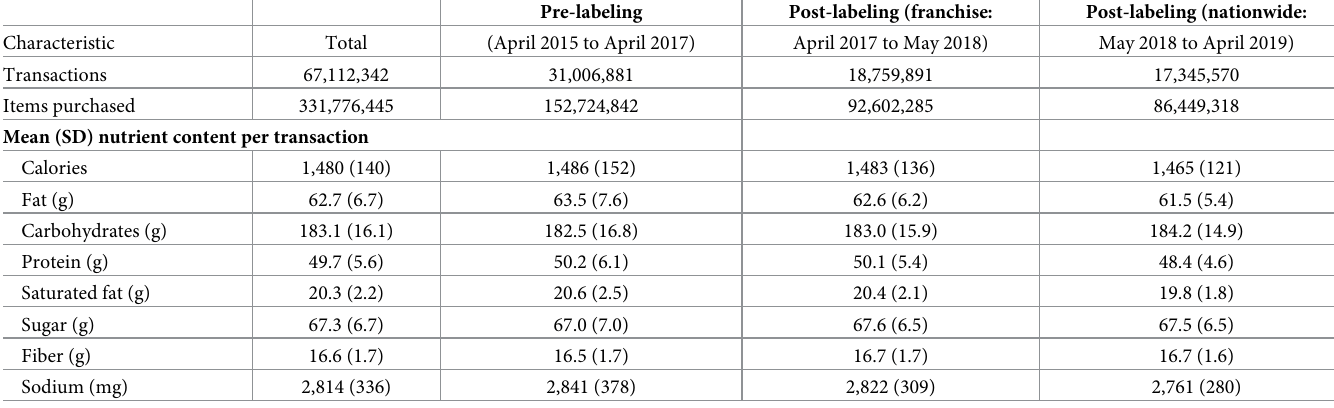
Table 1. Transactions, item purchases, and mean (SD) calorie and nutrient content of purchased meals in restaurants overall and by calorie labeling implementa- tion period.